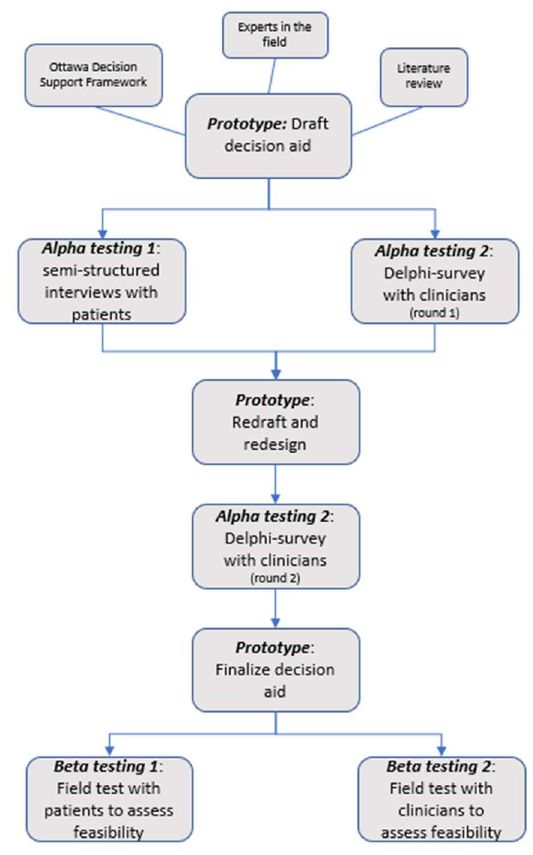
Figure 1 . Development process . Figure 1. Development